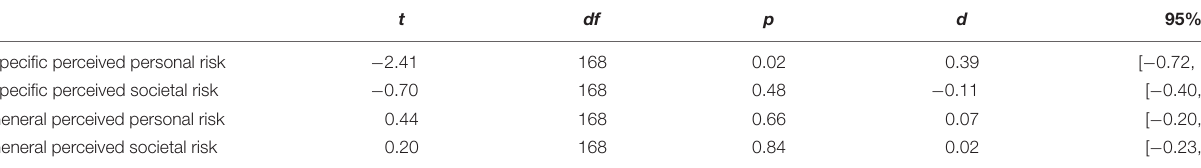
TABLE 1 | Independent t -tests comparing scores on perceived risk measures for order of presentation. t df